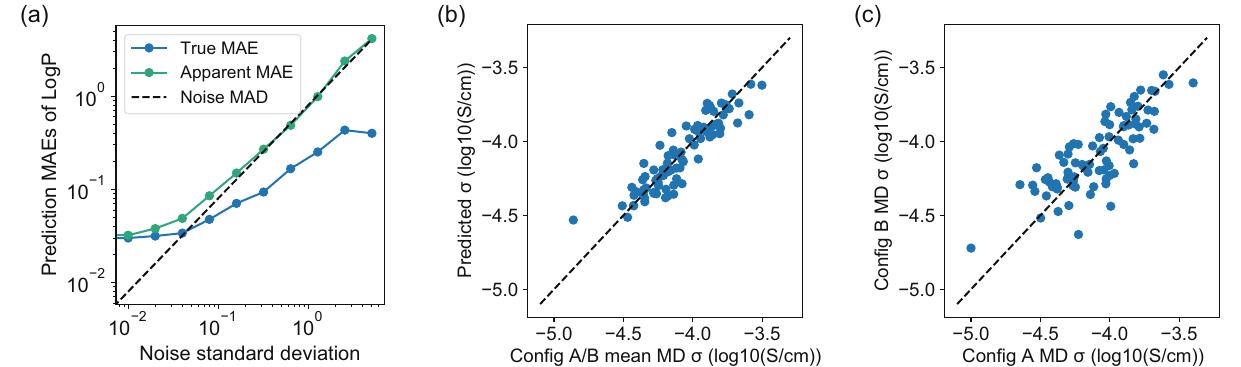
Fig. 2 Performance on reducing random errors. a Mean absolute errors (MAEs) on a toy dataset to predict LogP with increasing noises in training data. Blue line denotes MAEs with respect to true LogP values, green line denotes MAEs with respect to noisy LogP values, and dashed line denotes the mean absolute deviation (MAD) of the Gaussian noise. b Scatter plot comparing the predicted conductivity and computed mean conductivity from two independent initializations (con fi g A and con fi g B) in the test dataset. c Scatter plot comparing conductivities from two independent initializations for the same polymers in the test